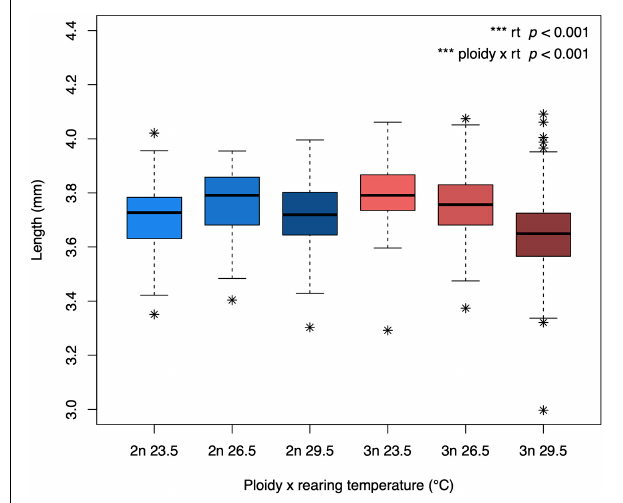
FIGURE 4 | Development of diploid and triploid larvae up to 72 hpf reared at different temperatures. Light, medium, and dark blue lines represent development of diploid larvae reared at 23.5 ◦ C, 26.5 ◦ C, and 29.5 ◦ C, respectively. Light, medium, and dark red lines represent development of triploid larvae reared at 23.5 ◦ C, 26.5 ◦ C, and 29.5 ◦ C, respectively. Note that at 26.5 ◦ C and 29.5 ◦ C the red and blue lines almost entirely overlap. In this graph, the dashed gray line is the reference x = y. Solid gray lines are the hours post-fertilization at which the embryos and larvae were staged, namely: 6, 24, 30, 48, and 72 h. Effects of rearing temperature and the interaction between hpf and rearing temperature were significant (ANOVA, p < 0.001, n = 393).